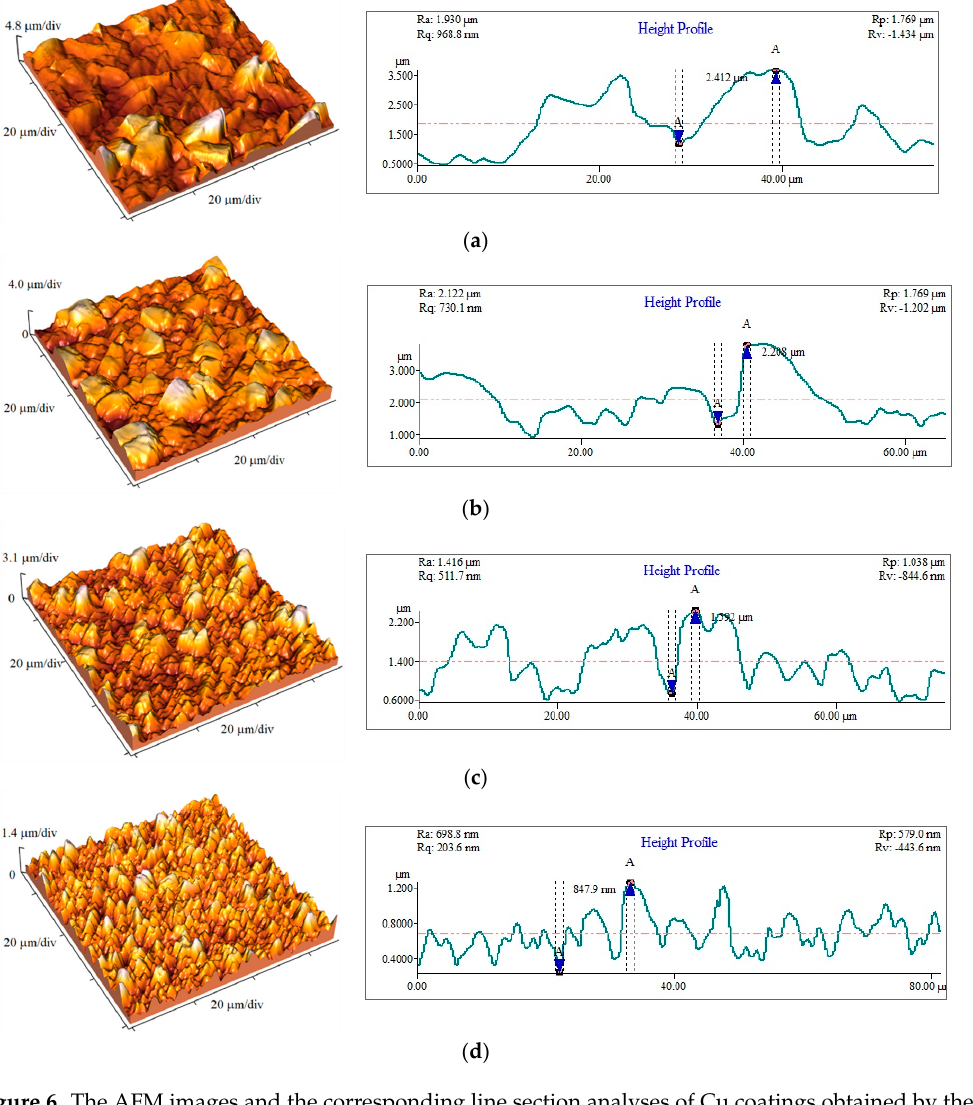
Figure 6. The AFM images and the corresponding line section analyses of Cu coatings obtained by the PC regimes: ( a ) 30 Hz ( t p = 28.3 ms), ( b ) 50 Hz ( t p = 15 ms), ( c ) 80 Hz ( t p = 7.5 ms) and ( d ) 100 Hz ( t p = 5 ms). In all experiments: j A = 100 mA cm – 2, and t c = 5 ms. Thickness of coatings: δ = 40 µm. Scan area: 70 × 70 µm 2 .